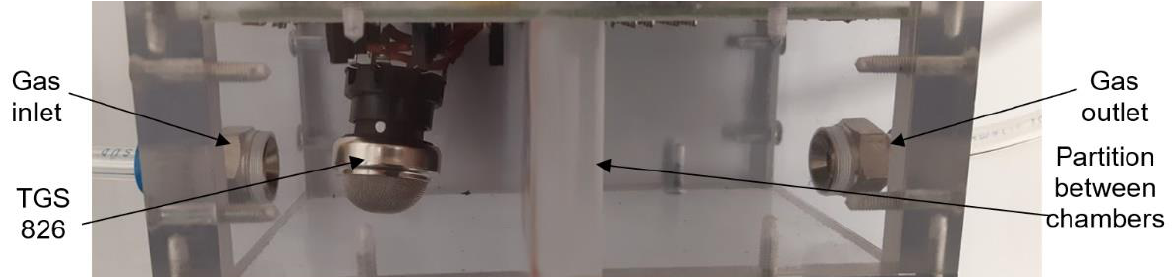
Figure 8. Photograph of conductivity sensor TGS 826 in test chamber.